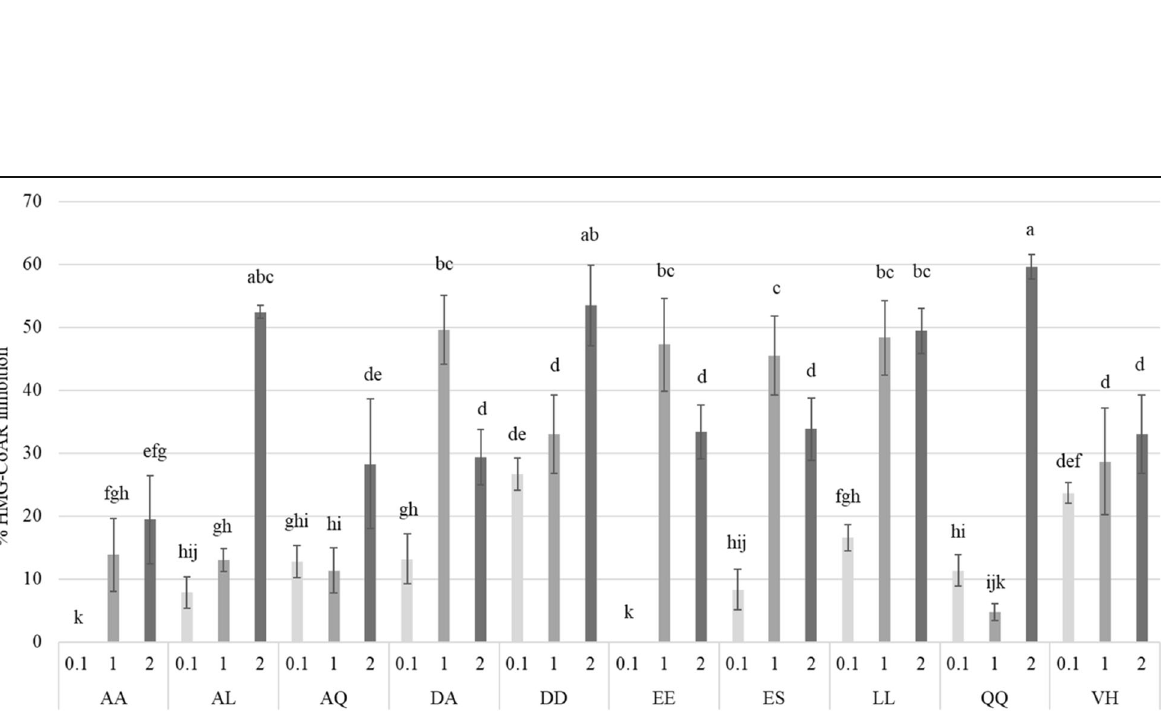
Fig. 2 Inhibition percentages of most bioactive dipeptides at different concentrations 0.1, 1, and 2 mM (n > 3). Letters designate significant differences among the values at P <